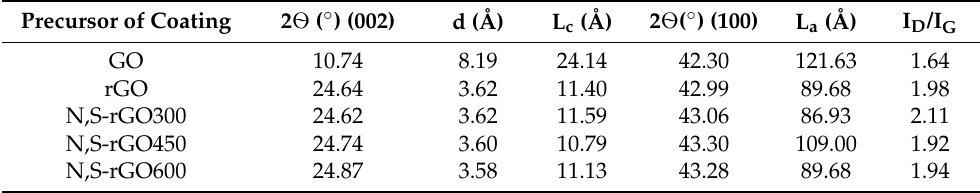
Table 1. X-ray diffraction (XRD) parameters for precursors of coatings.